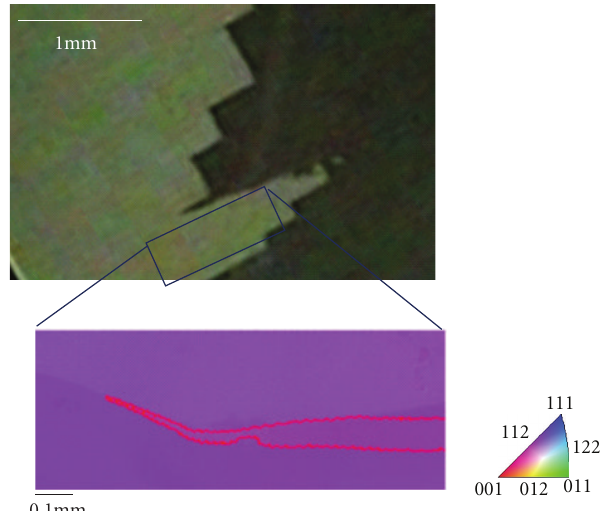
Figure 13: Result of EBSP analysis of faceted dendrite after crystalli- zation. The EBSP analysis was performed at the origin of dendrite growth. The direction along the dendrite growth was shown in color (cid:4) 3 grain boundaries were using the inverse pole figure triangle. indicated by red lines, and other grain boundaries were indicated by black lines when they existed in the